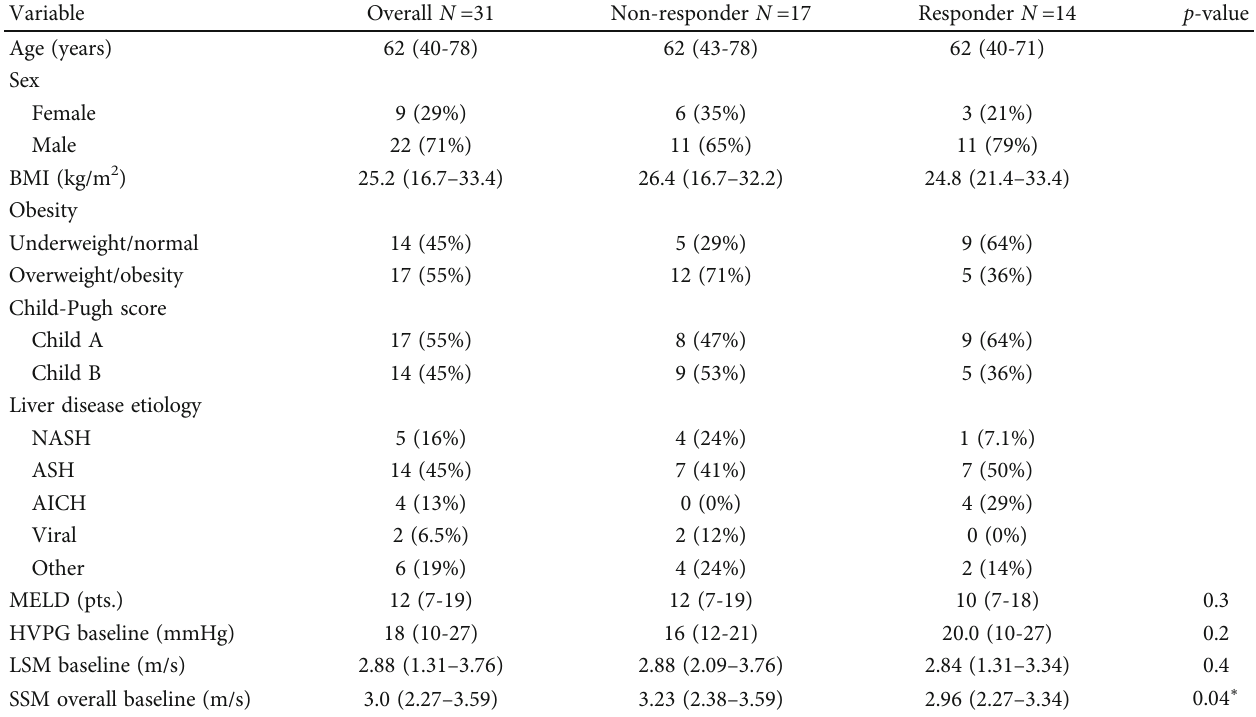
Table 1: General characteristics of the patients included in the study (BMI =body mass index; MELD=model for end-stage liver disease;